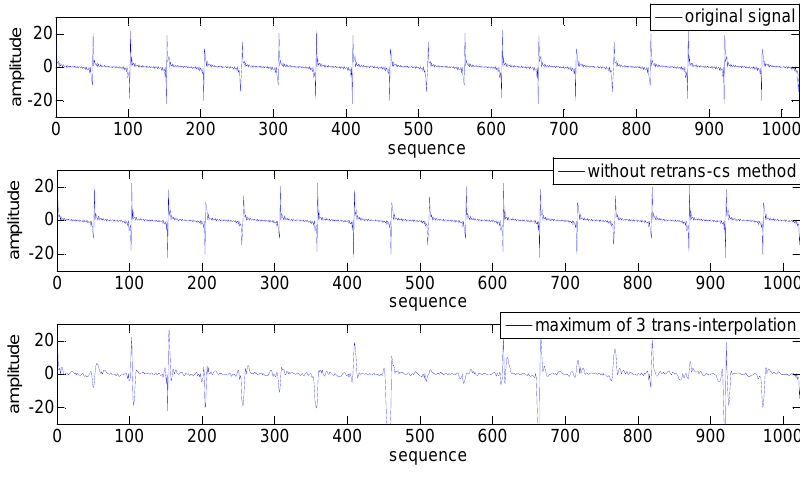
Figure 14. Reconstruction comparison.